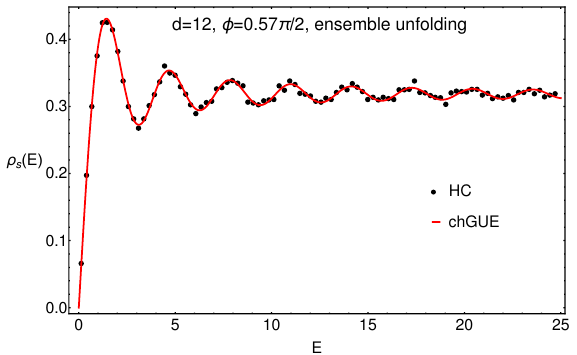
Figure 8 . The microscopic spectral densities. Black dots: numerically calculated from 10,000 realizations of the d = 12 , φ = 0 . 57 π/ 2 Hamiltonian. Red curve: analytically predicted by the chGUE random matrix